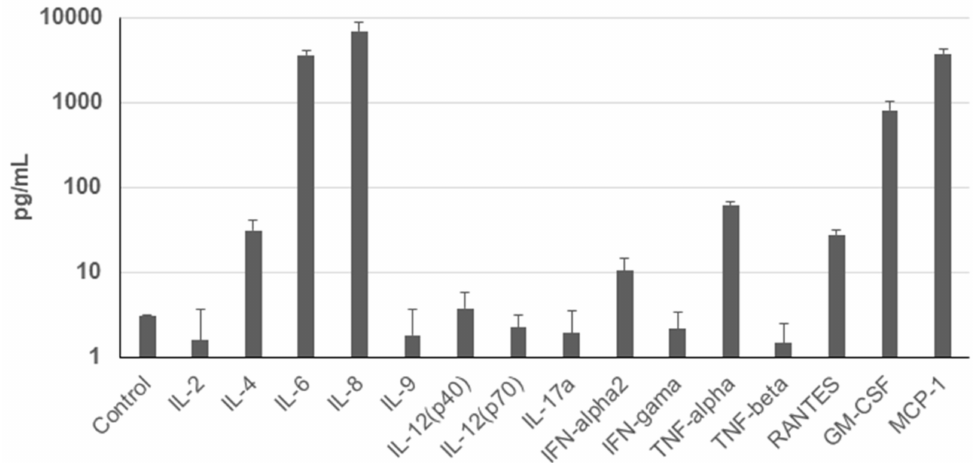
Figure 4. Cytokine profile of the human UDSCs. Analysis of the cells’ secretory activity revealed that IL-8 was secreted at the highest concentration (6958.33 pg/mL) followed by MCP-1 (3789.54 pg/mL), IL-6 (3650.03 pg/mL), and GM-CSF (817.89 pg/mL). Moderate levels within conditioned media were measured for TNF-alpha (62.4 pg/mL), IL-4 (31.29 pg/mL), RANTES (27.99 pg/mL) and INF-alpha2 (10.35 pg/mL). Concentration of other cytokines and chemokines was lower compared to the control (unconditioned)